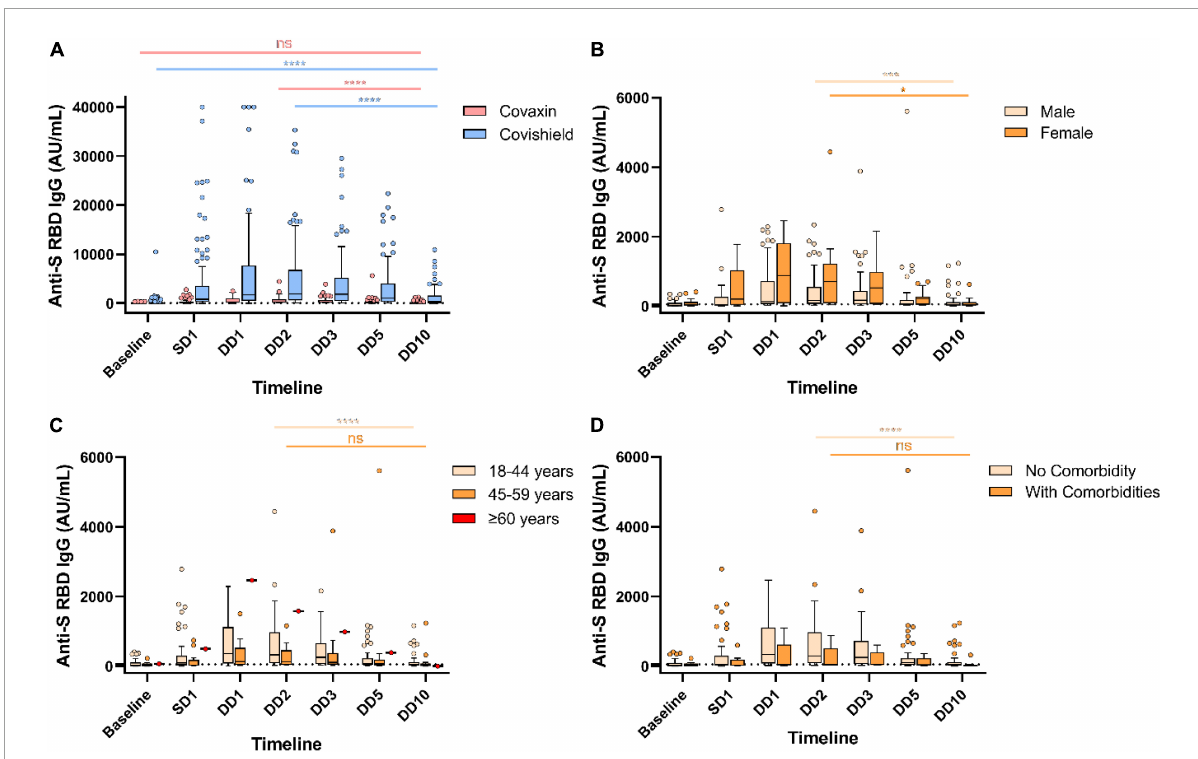
FIGURE1 Decreased humoral immune response against severe acute respiratory syndrome coronavirus-2 (SARS-CoV-2) vaccines over the year. Anti-spike RBD IgG antibody responses at different timepoints in Covaxin and Covishield double dose recipients without any breakthrough infection (A) . Anti-S RBD IgG antibody levels of Covaxin recipients stratified by gender (B) , age (C) , and comorbidities (D) . ns, non-significant; * p < 0.05; *** p < 0.001; **** p < 0.0001. Tukey method was used to plot whiskers. SD1, 1 month after single dose; DD1, 1 month; DD2, 2 months; DD3, 3 months; DD5, 5 months; DD10, 10 months after double